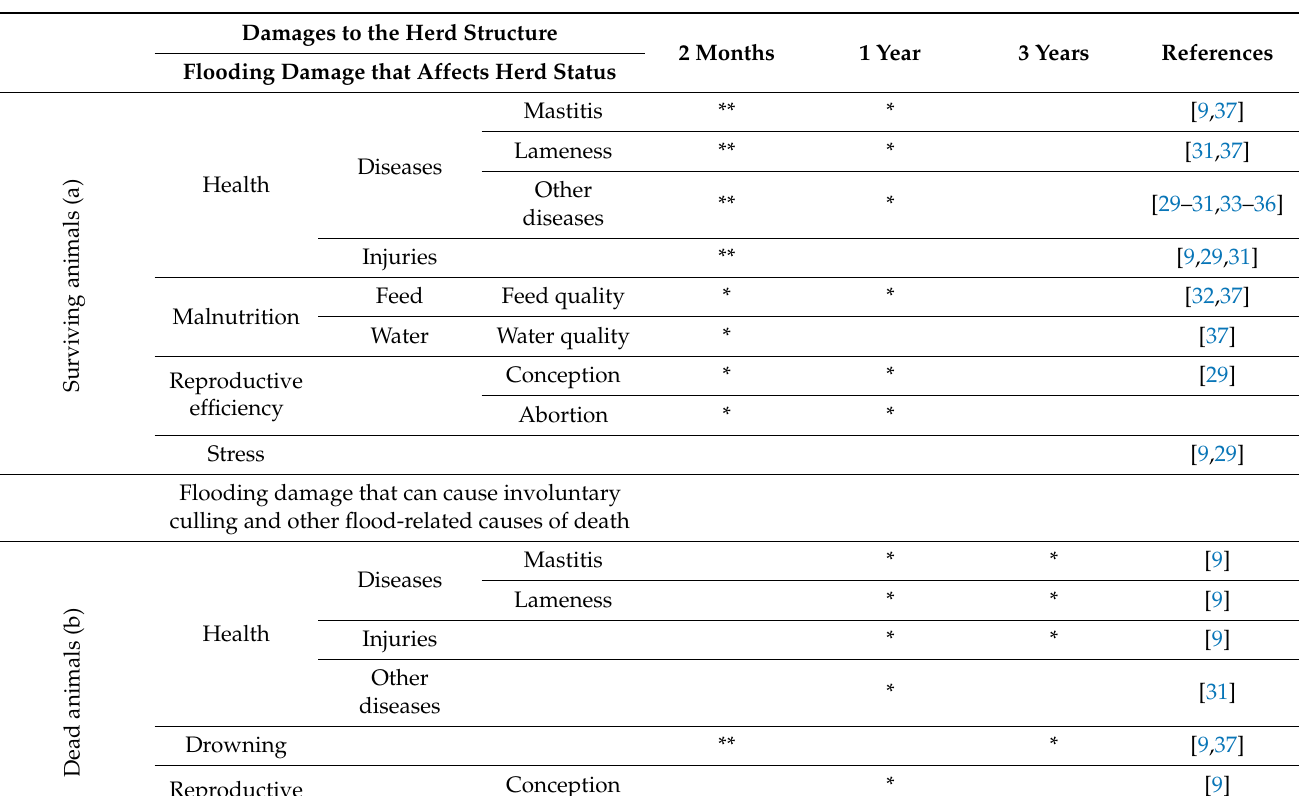
Table 2. Direct flood damages to the herd.